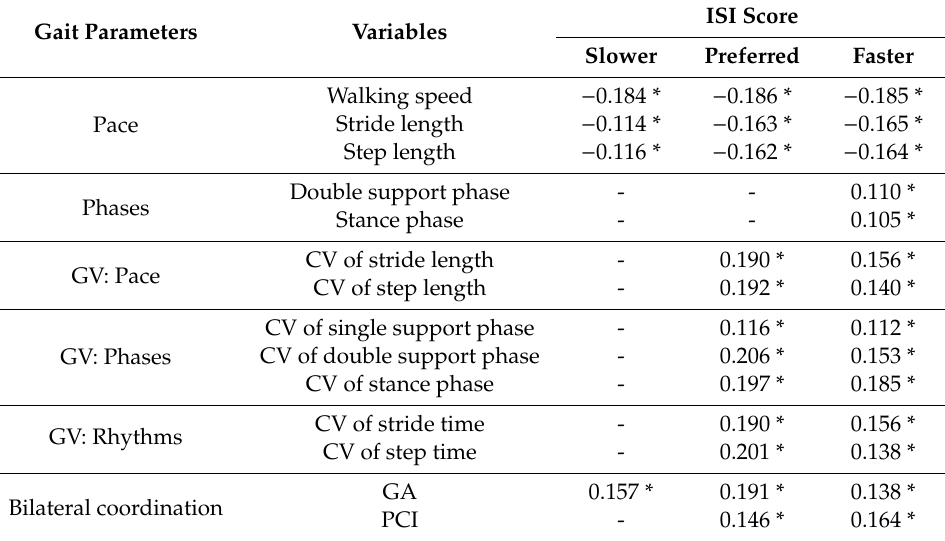
Table 5. Pearson’s product-moment correlation analysis between the total insomnia severity index (ISI) score and gait-related variables of all the participants at slower, preferred, and faster